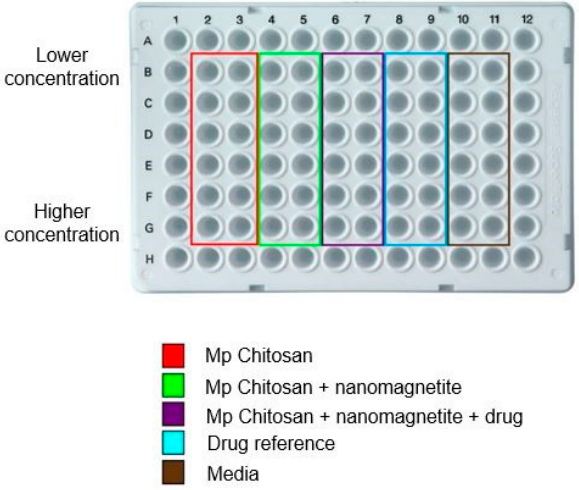
Figure A1. Disposition of composite to test.